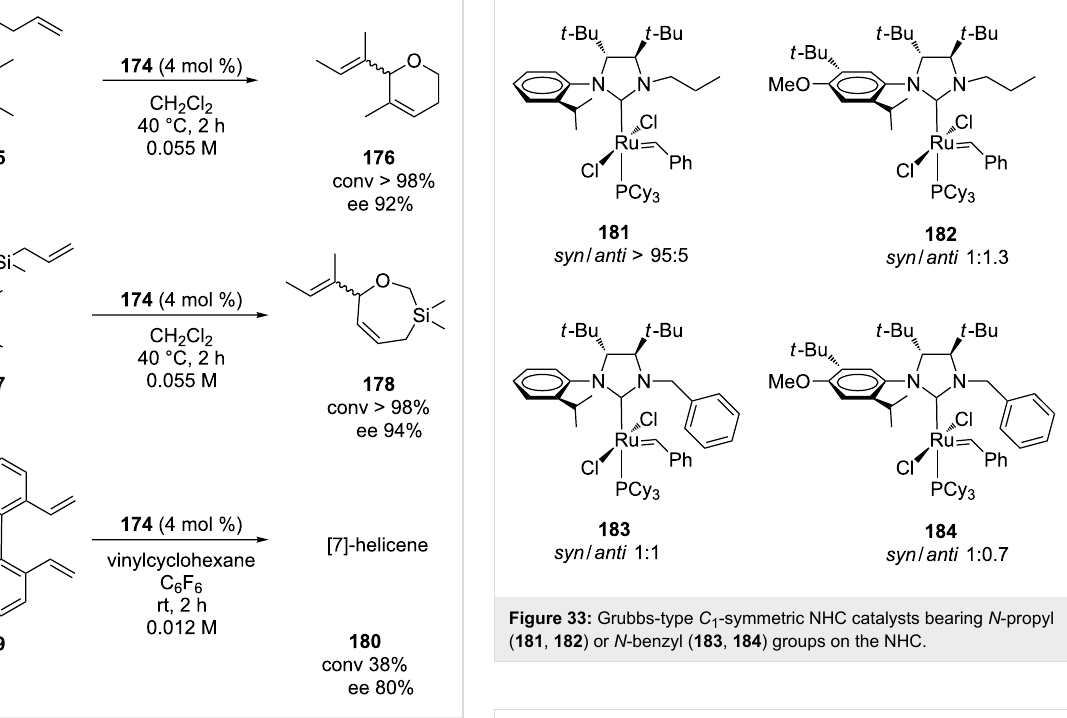
Figure 33: Grubbs-type C 1 -symmetric NHC catalysts bearing N -propyl ( 181 , 182 ) or N -benzyl ( 183 , 184 ) groups on the NHC.